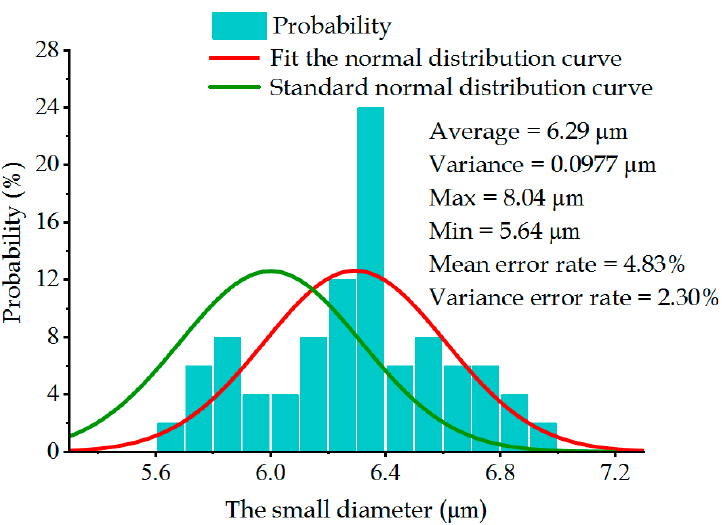
Figure 17. Relationship between the small diameter and probability of metal